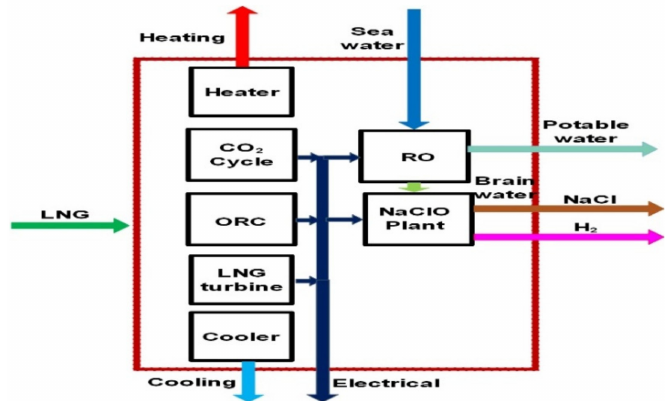
Figure 2. Energy flow between the